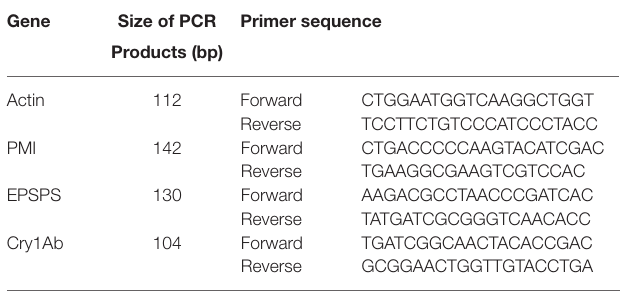
TABLE 1 | Primer sequences for the amplification of endogenous and exogenous